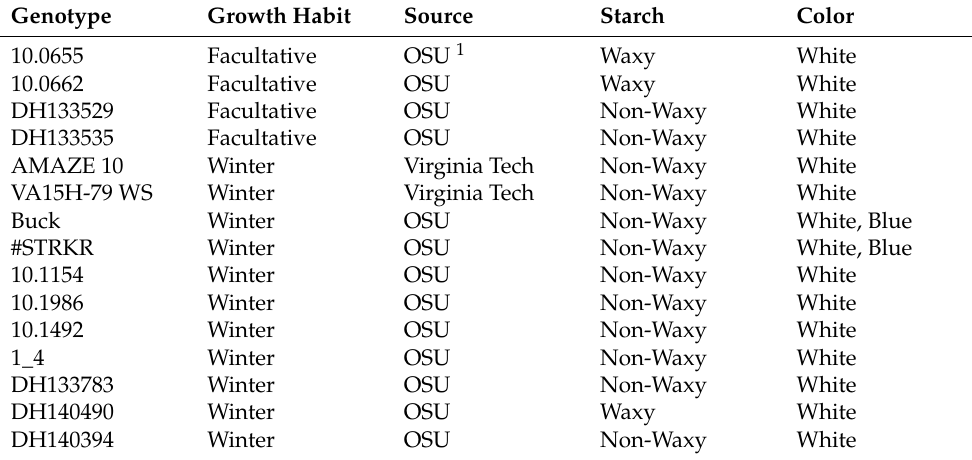
Table 1. Genotypes, growth habit, seed source, starch type, and color of winter barley